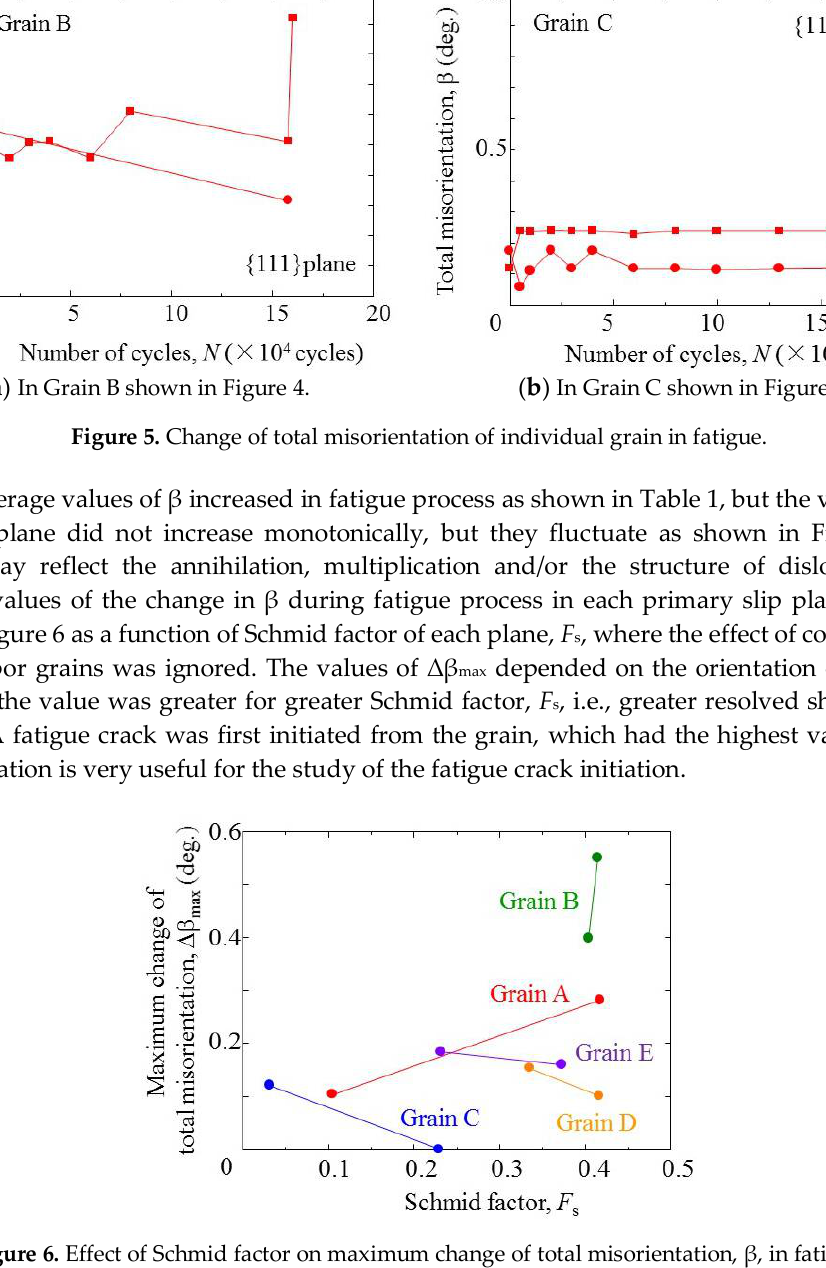
Figure 6. Effect of Schmid factor on maximum change of total misorientation, β, in